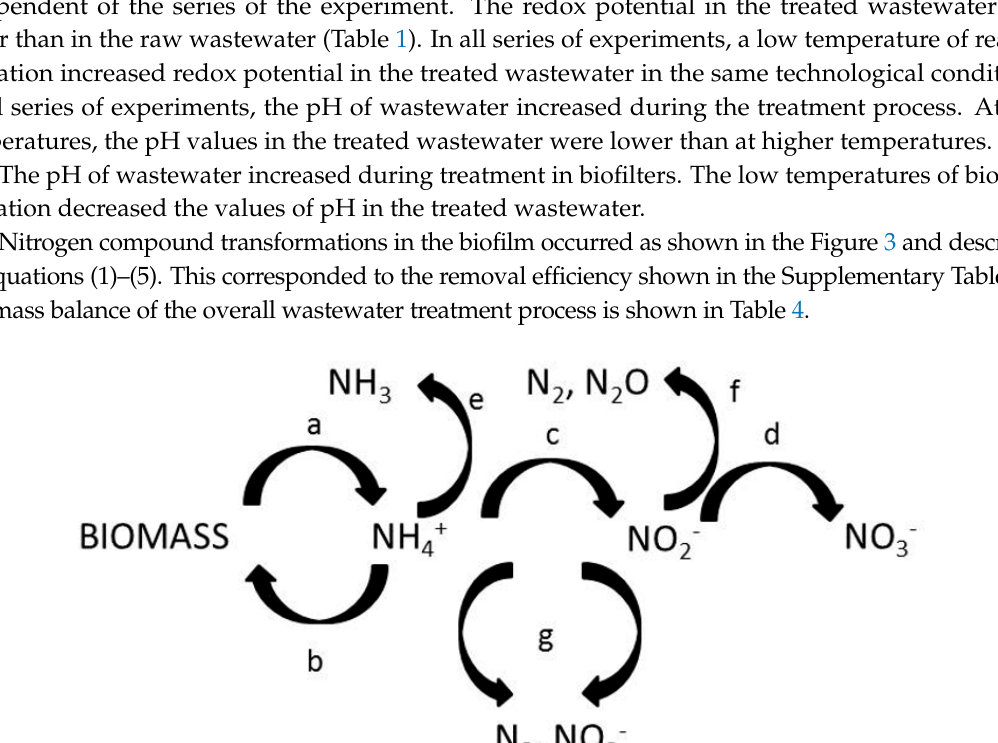
Table 3. Physicochemical properties of treated wastewater.